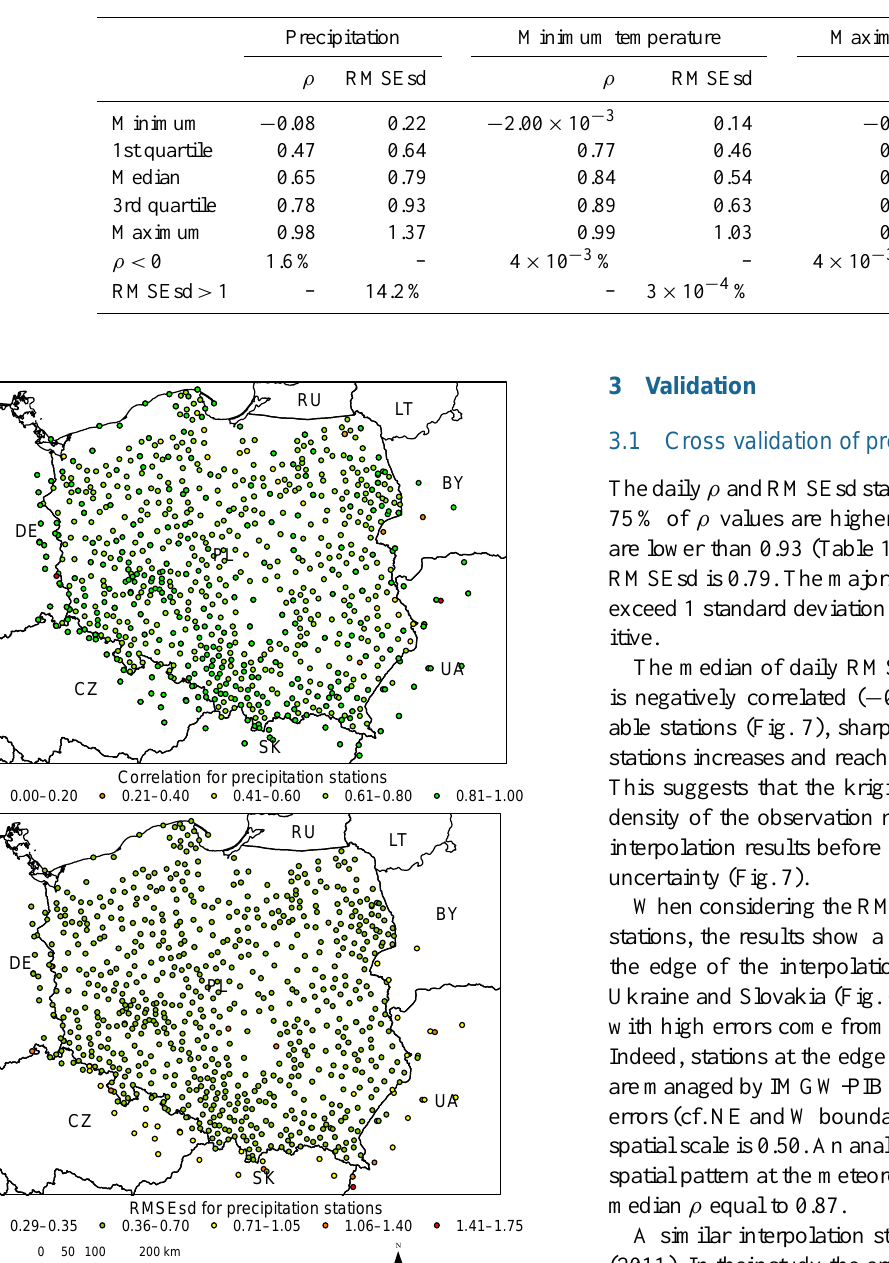
Table 1. Descriptive statistics for the kriging cross-validation results for precipitation, minimum temperature, and maximum temperature. “ ρ < 0” denotes percentage of ρ values lower than 0. “RMSEsd > 1” denotes percentage of RMSEsd values higher than 1.